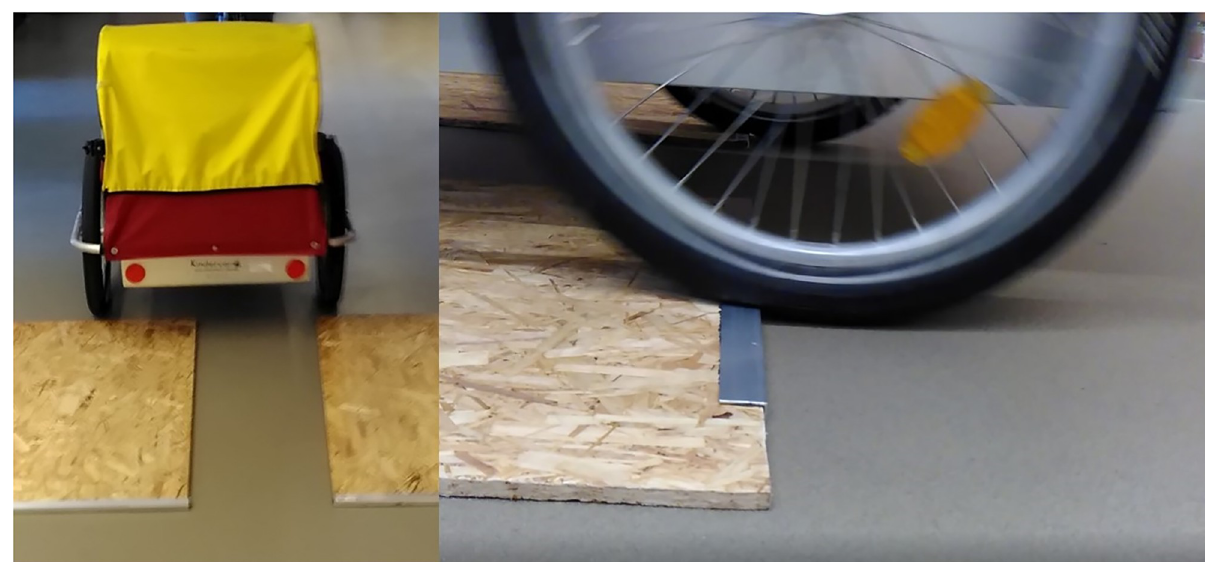
Fig 3. Picture of the step input utilised during the indoor-experiments. Cycle carrier running over two oriented strand boards with with a gap for the pulling bicycle (left). Cycle carrier wheel running over an oriented strand board with aluminium reinforced edge (right).